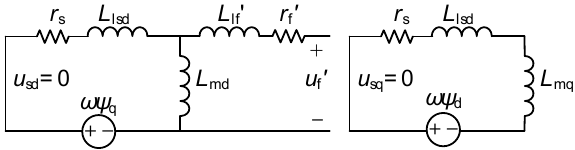
Figure 6. The equivalent circuit of HTR-ASD.